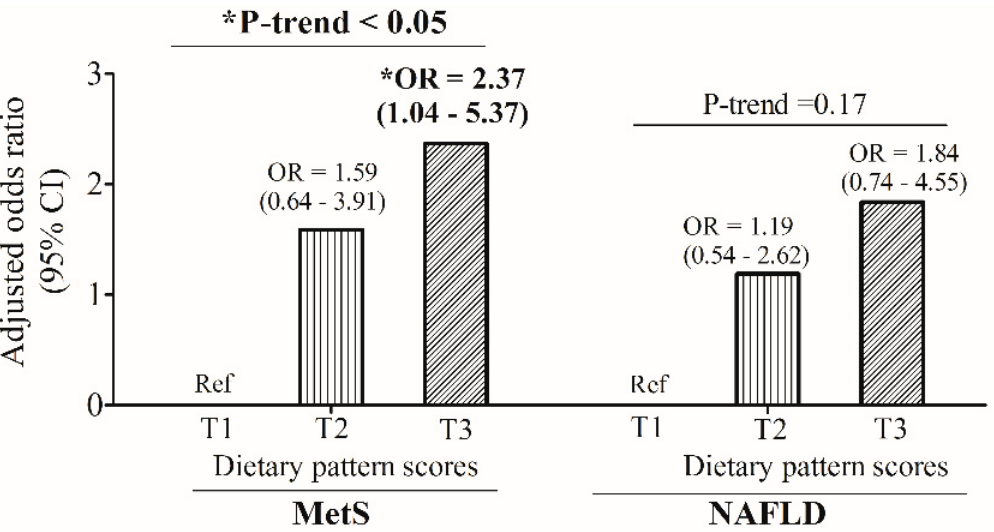
Figure 3. Age- and sex-adjusted odds ratios (ORs) and 95% confidence intervals (CIs) of dietary pattern score tertile levels for metabolic syndrome (MetS) and non-alcoholic fatty liver (NAFLD). * p ≤ 0.05.